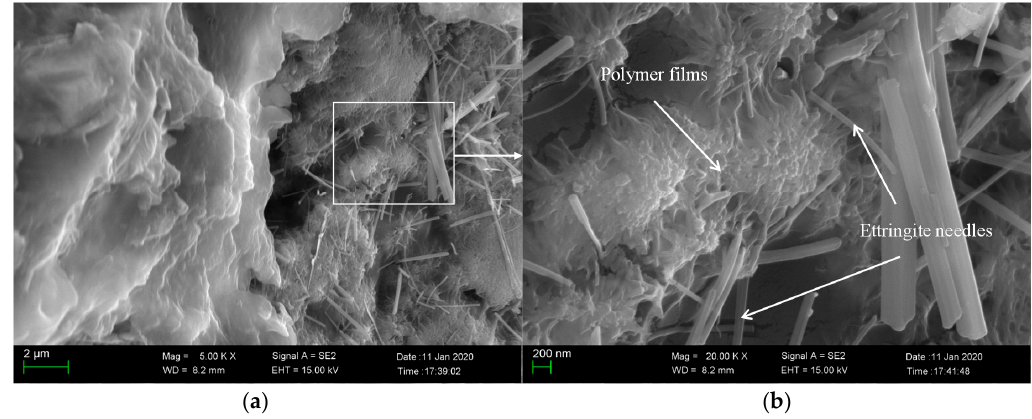
Figure 11. Scanning electronic microscope (SEM) image of fractured sections of epoxy latexes modified cement mortar under dry curing regimes with the addition of 15% epoxy resin at 45 d: ( a ) 5000× and ( b ) 20,000×.